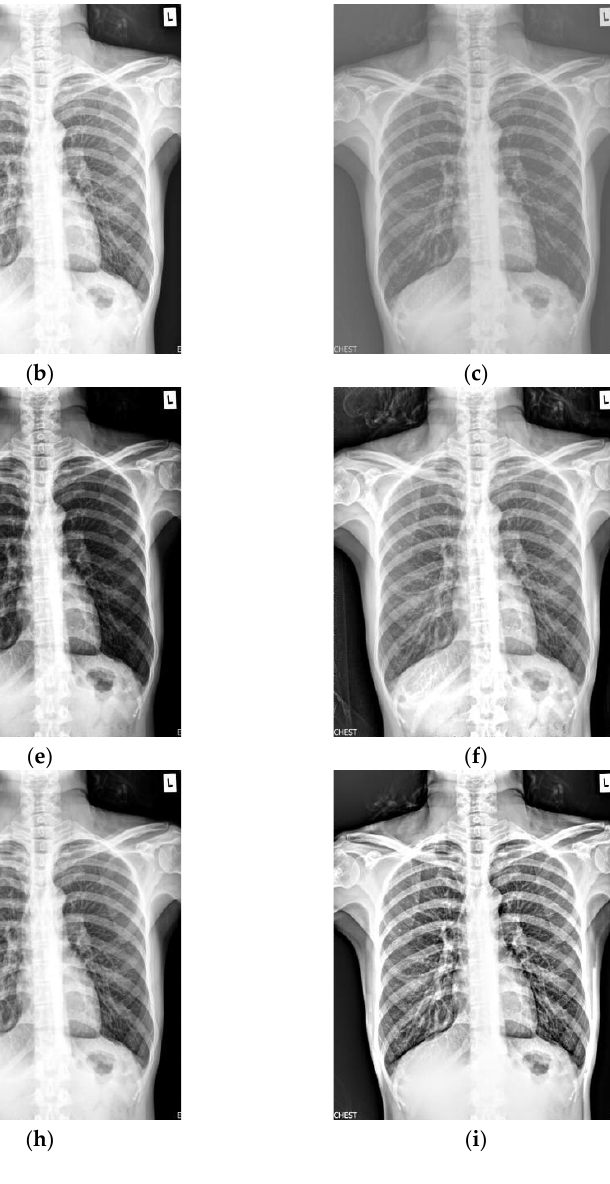
Figure 1. Comparison on X-ray image 1. ( a ) Original image; ( b ) McCann; ( c ) RLBHE; ( d ) RESIHE; ( e ) TBCSSR; ( f ) GDGIF; ( g ) SMIPC; ( h ) FuzzyII; ( i ) Proposed method. Table 1. The metric data of eight methods on X-ray image 1.